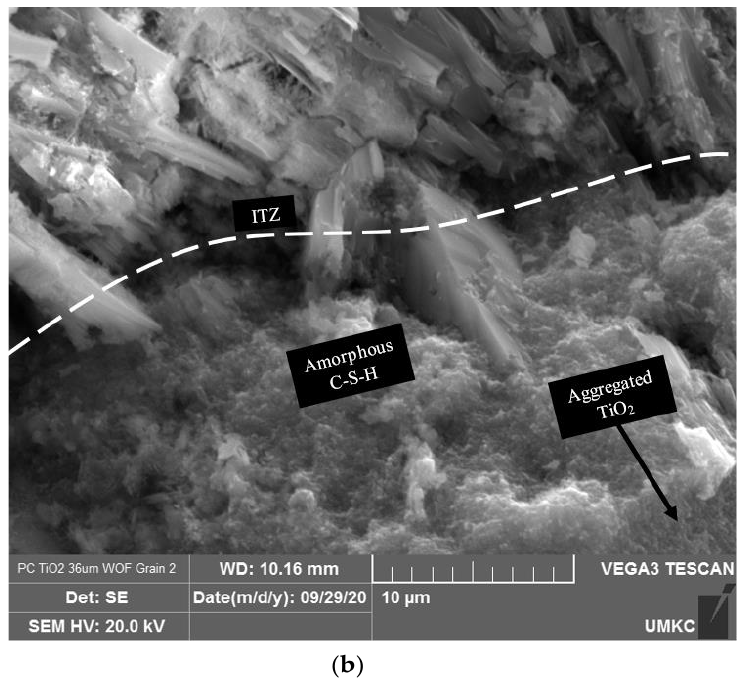
Figure 10. ( a ) SEM secondary electron image of TiO 2 immobilized with the cement structure. The blue box marks the location of image 11b. ( b ) SEM secondary electron image of the interlocking of C-S-H and TiO 2 along the boundary of the aggregated TiO 2 .